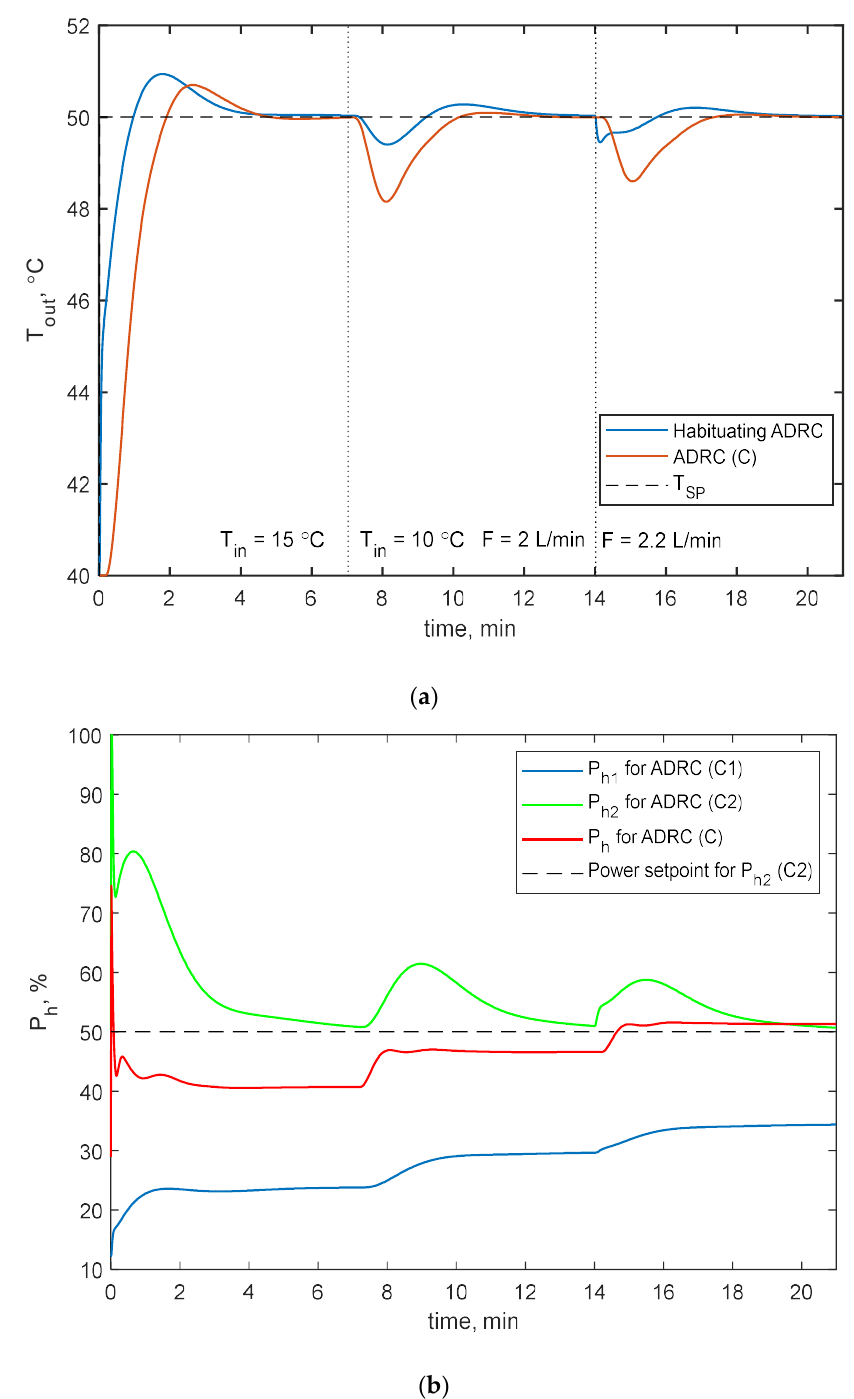
Figure 7. Validation results of the performance of the proposed ADRC-based HCS operated in the habituating control structure in comparison with the traditional ADRC-based single closed loop control structure shown in Figure 1. Diagram ( a ) shows the regulated temperature T out , and diagram ( b ) shows the corresponding variations of manipulated variables for each case.